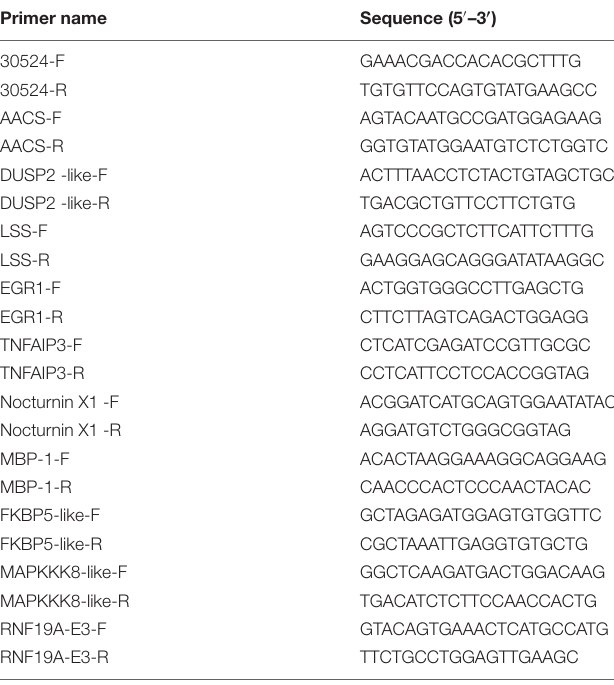
TABLE 1 | Sequences of primers used in qRT-PCR analysis.